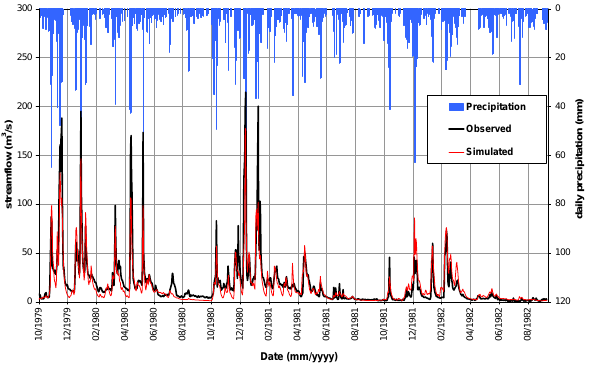
Fig. 7. Observed daily streamflows, hourly precipitation and sim- ulated hourly streamflows at simulation point Be3, for part of the validation